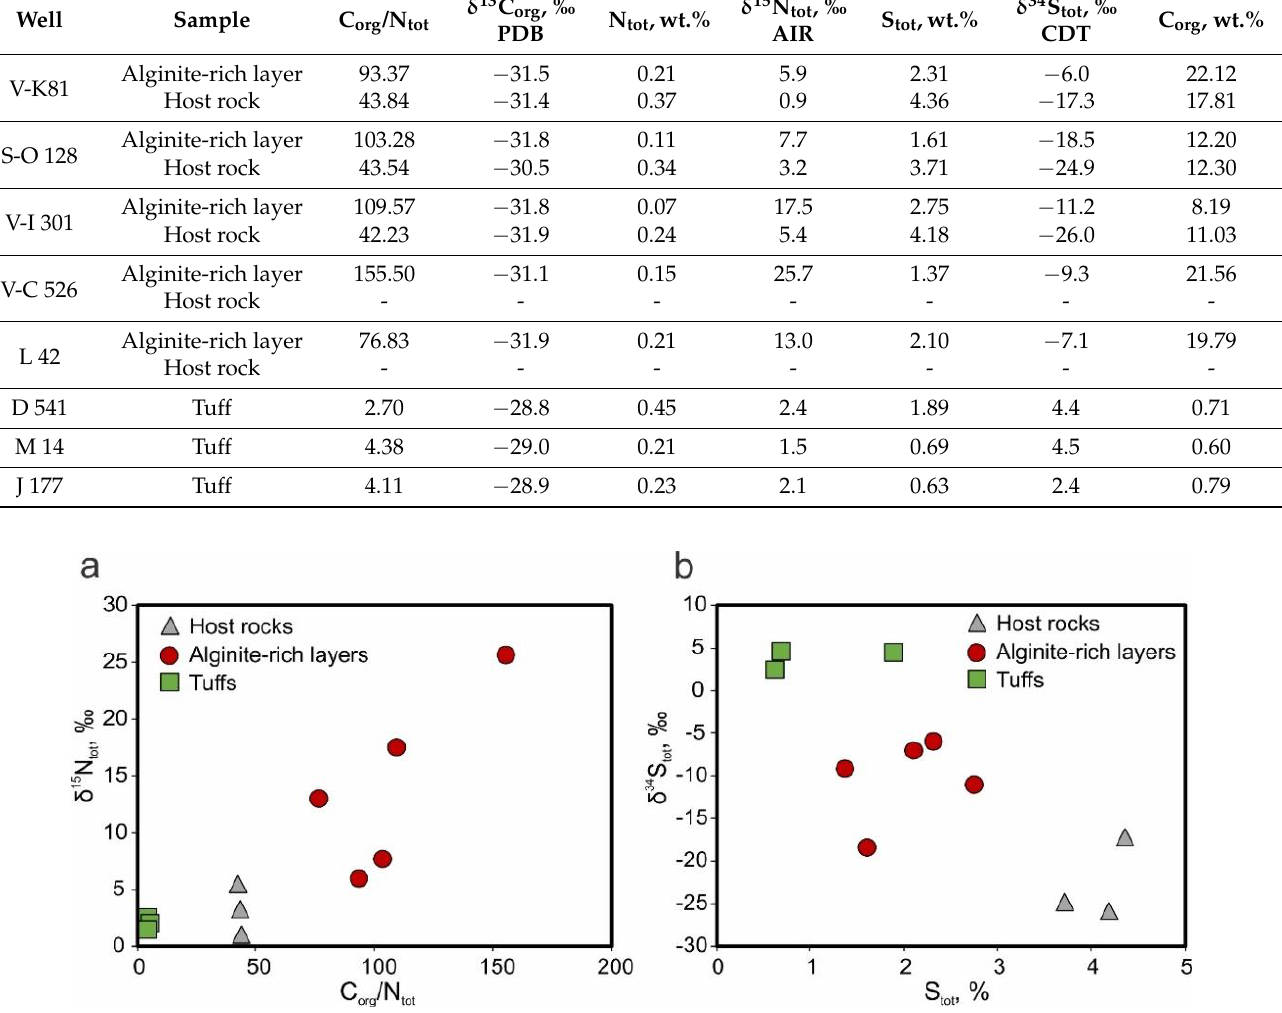
Table 3. Bulk C, N, and S elemental and isotope composition for the alginite-rich layers, host rocks, and tuffs. Well